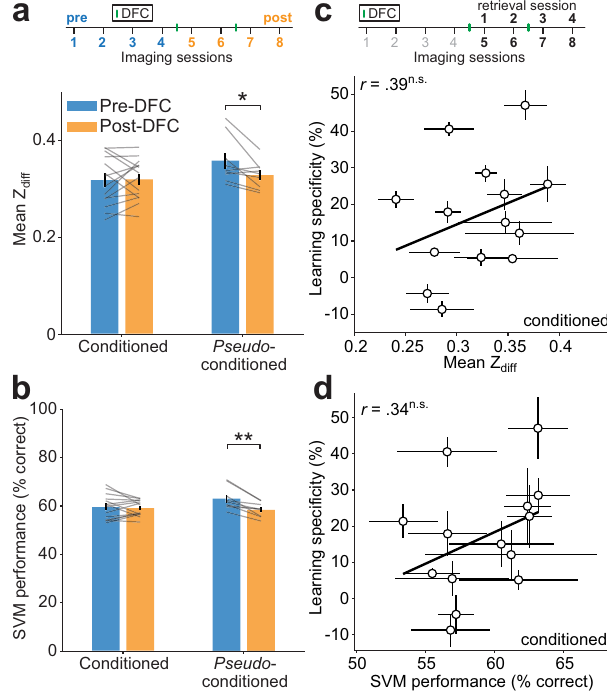
Fig. 4 Changes in neuronal discrimination post-DFC. a Comparison of mean ± sem Z diff between the pre- (sessions 1 – 4, blue) and post-DFC sessions (5 – 8, orange) in conditioned ( N = 14) and pseudo -conditioned ( N = 9) mice. Statistics: Two-way rm-ANOVA, Tukey – Kramer post hoc, p = 0.028, Supplementary Table 1. b Same as ( a ) but for comparison of mean ± sem SVM performance between the pre- and post-DFC. Statistics: Two-way rm-ANOVA, Tukey – Kramer post hoc, p = 0.001, Supplementary Table 1. c Relationship between mean (±sem) Z diff across the post-DFC sessions (sessions 5 – 8) and mean learning speci fi city across all retrieval sessions. Statistics: two-tailed Spearman ’ s rank correlation, r (12) = 0.39, p = 0.175. Black line shows best linear fi t. d Same as ( c ) but for mean (±sem) SVM performance across the post-DFC sessions and mean learning speci fi city. Statistics: two-tailed Spearman ’ s rank correlation, r (12) = 0.34, p = 0.264. † p < 0.1, * p < 0.05, ** p < 0.01, *** p < 0.001, n.s. p > 0.10. Source data are provided as a Source data fi